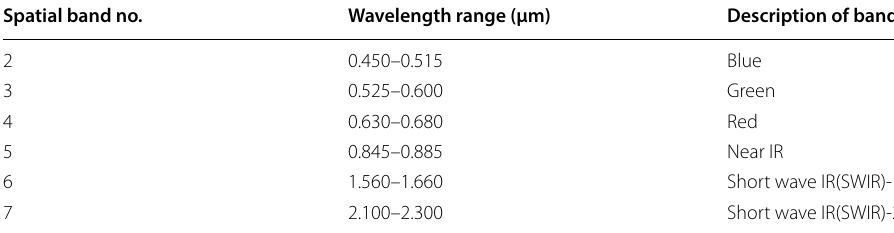
Table 1 Subset of the bands selected from the Landsat 8 image for experimentations Spatial band